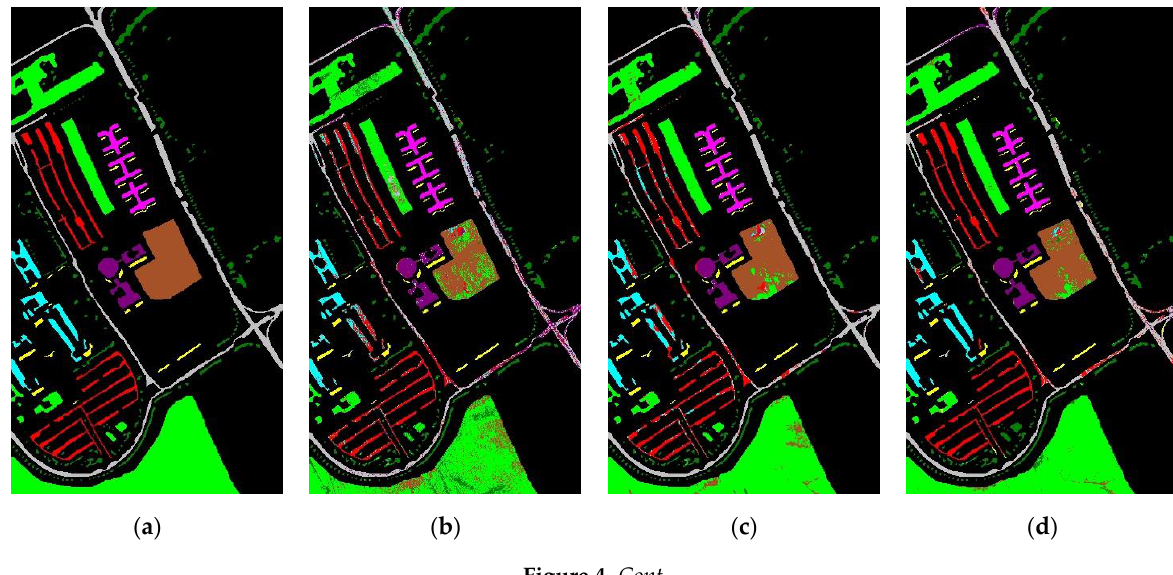
Figure 3. Classification maps for the Indian Pines image. ( a ) Ground truth; ( b ) SVM-RBF; ( c ) SVMCK; ( d ) SCMK; ( e ) RMK; ( f ) ASMGSSK; ( g ) WASCK; ( h ) MWASCK.